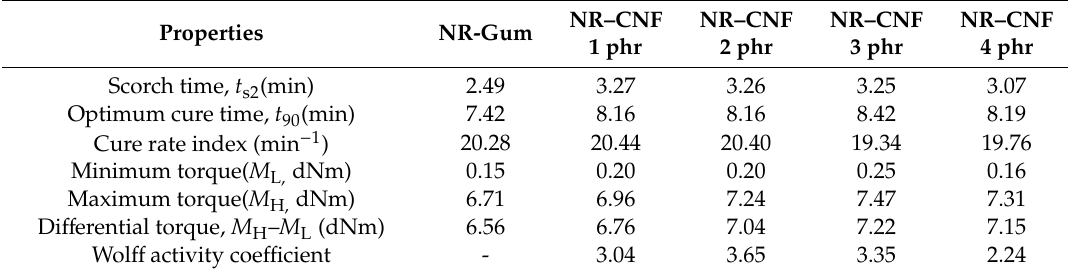
Table 3. Curing parameters and Wol ff activity coe ffi cient determined for NR–CNF